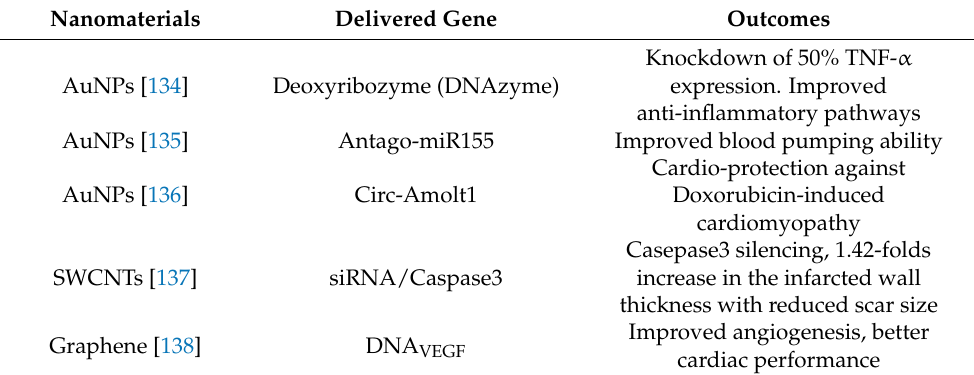
Table 6. Conductive nanomaterials as delivery vehicles for cardiac gene therapy.